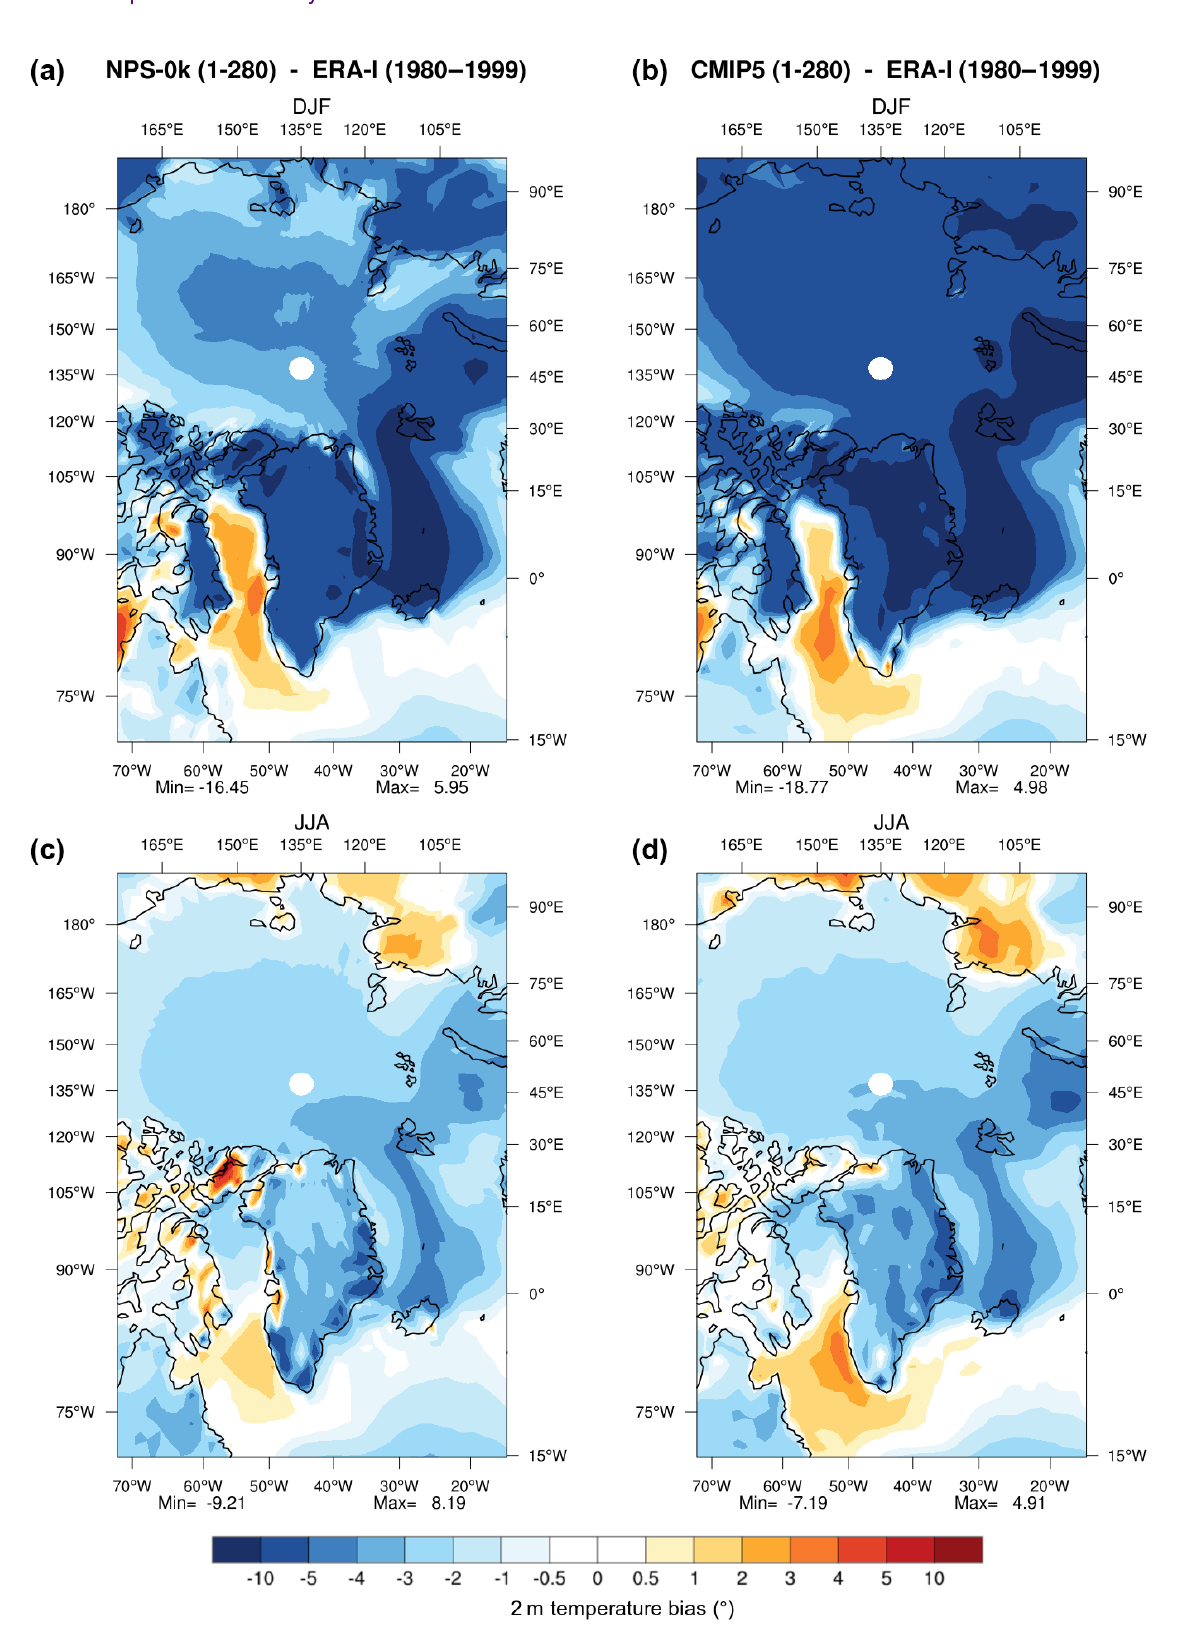
Figure 1. Temperature biases at 2m between the mean states from the preindustrial simulations (a, c) NPS-0k and (b, d) CMIP5 relative to the ERA-Interim (years 1980–1999) in (a, b) boreal winter (DJF) and (c, d) summer